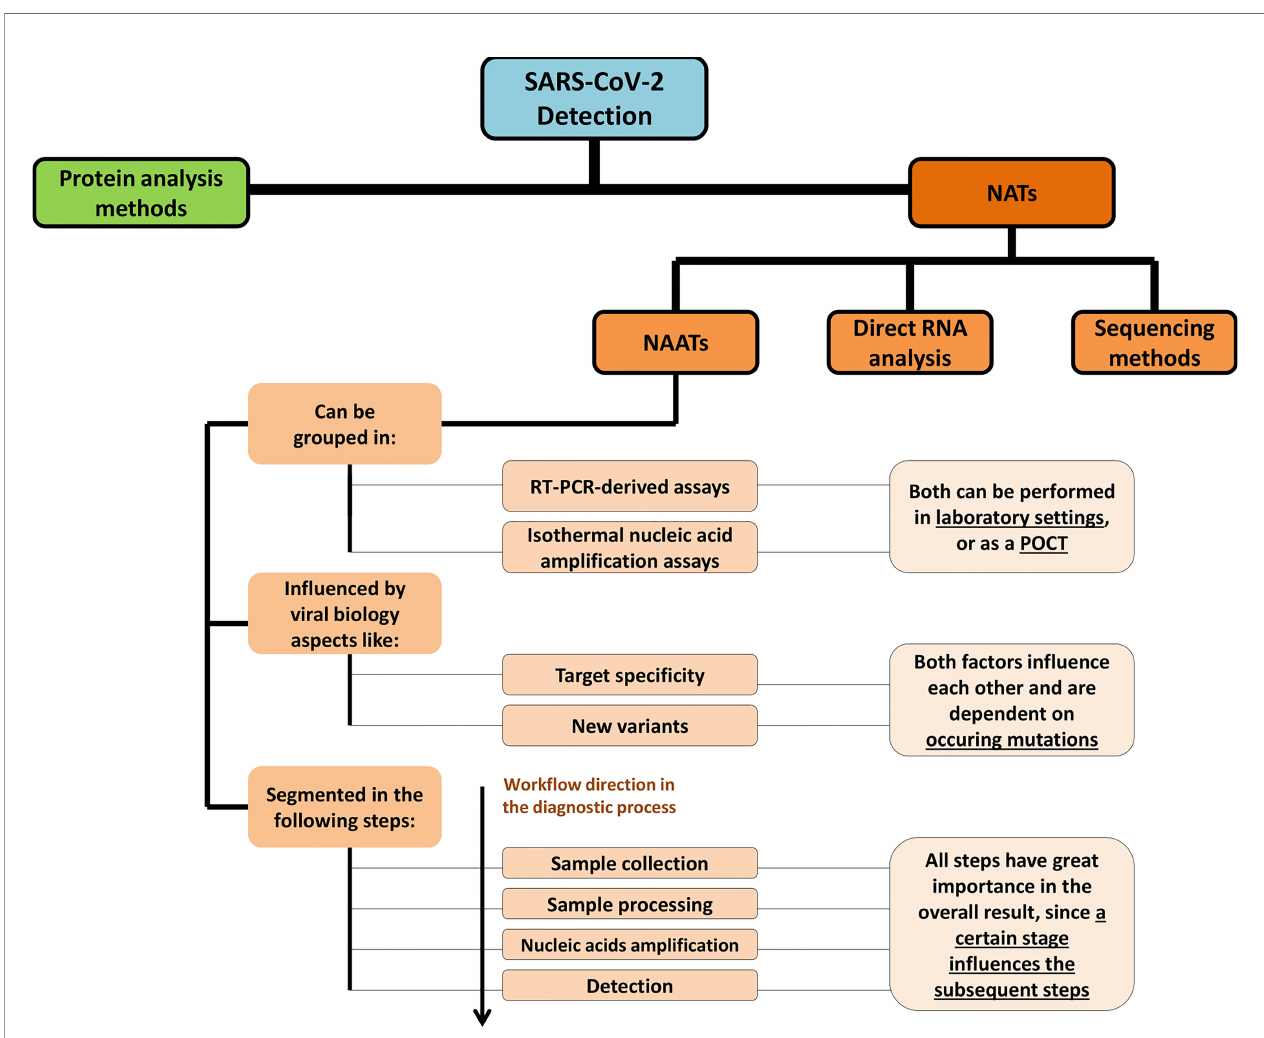
FIGURE 1 | Scheme depicting the different types of NATs, with a particular focus on NAATs. The main characteristics of NAATs are presented, including virology- based factors that in fl uence those tests, the type of ampli fi cation routes and ampli fi cation settings where these are performed and a brief description of the testing work fl ow, including its constituting